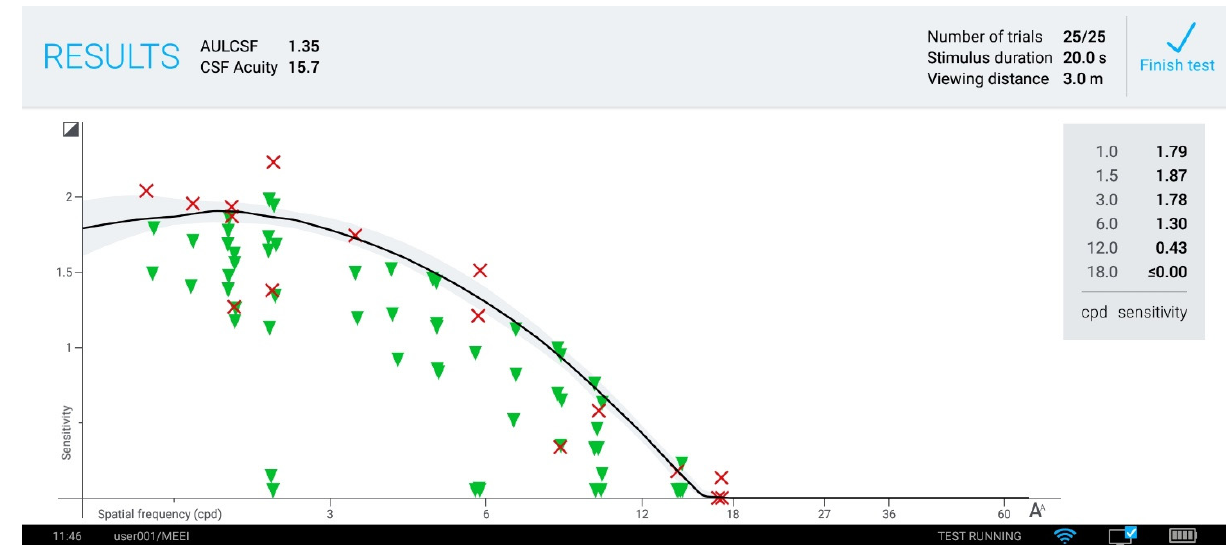
Figure 2. Screenshot of remote control tablet, showing test results after a session. The solid line denotes median sensitivity estimate for the possible CSFs, with the shaded region denoting the 66% confidence interval. Contrast acuity measures the smallest optotype visible with the highest level of contrast, as illustrated by the intersection of the contrast sensitivity function curve with the x -axis (previously unpublished figure).